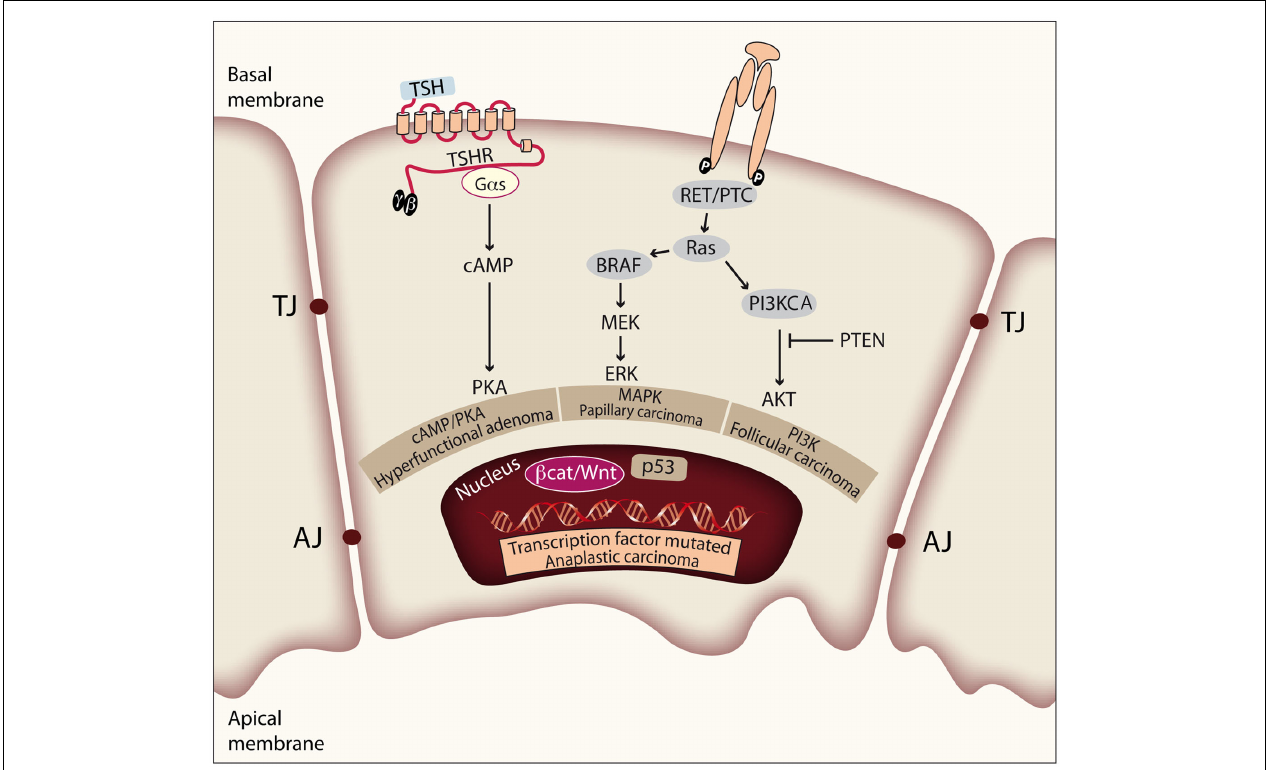
form follicular structures. Activating mutations in TSHR or G α s lead to constitutive activation of the cAMP/PKA pathway and give rise to hyperfunctional adenomas.There is evidence that constitutive activation of the MAPK pathway is required for PTC initiation. Activation of the PI3K/Akt pathway is required for FTC initiation. Finally, deregulation of the p53 pathway and theWnt/ β -catenin pathway is observed in ATC and has more to do with tumor